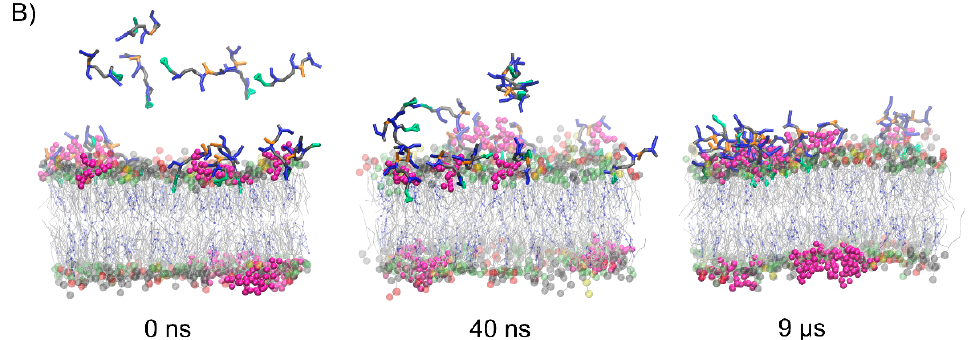
Figure 4. Representative snapshots from the POPC:POPE:POPS:DPG1:DPSM:CHOL binding CG MD simulations for multipeptide systems with Tat(49–57)-NH 2 ( A ) and PTD4 ( B ). The headgroups of POPC, POPE, POPS, and DPSM are colored gray, lime, yellow, and red, respectively. The sugar part of DPG1 is in magenta, while lipid acyl chains are presented in gray. CHOL is presented in blue as CPK model.